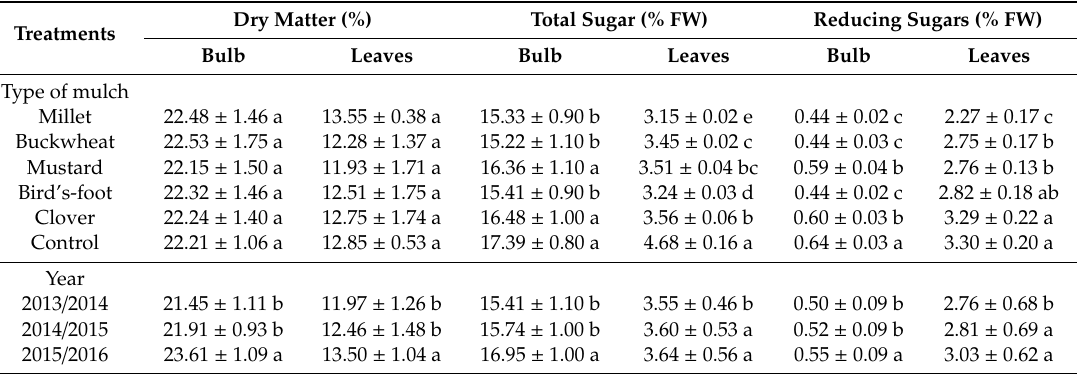
Table 5. E ff ect of mulch type and year of cultivation on the content of dry matter, total and reducing sugars in winter garlic edible parts.